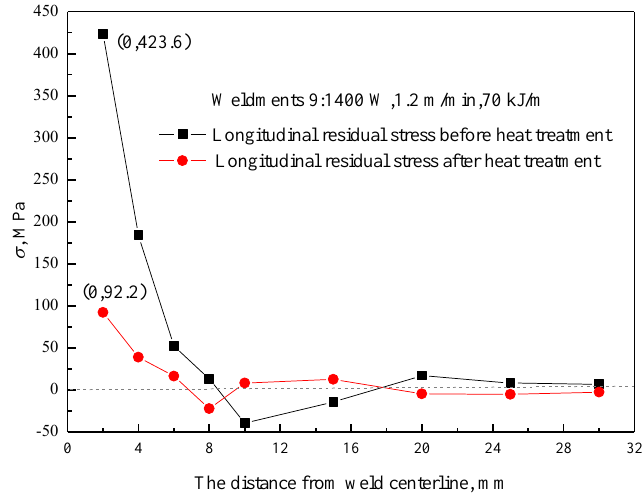
Figure 11. Comparison of the longitudinal residual stress before and after heat treatment. The maximum of longitudinal residual stress was reduced from 423 MPa to 92 MPa, a decrease of 78%.